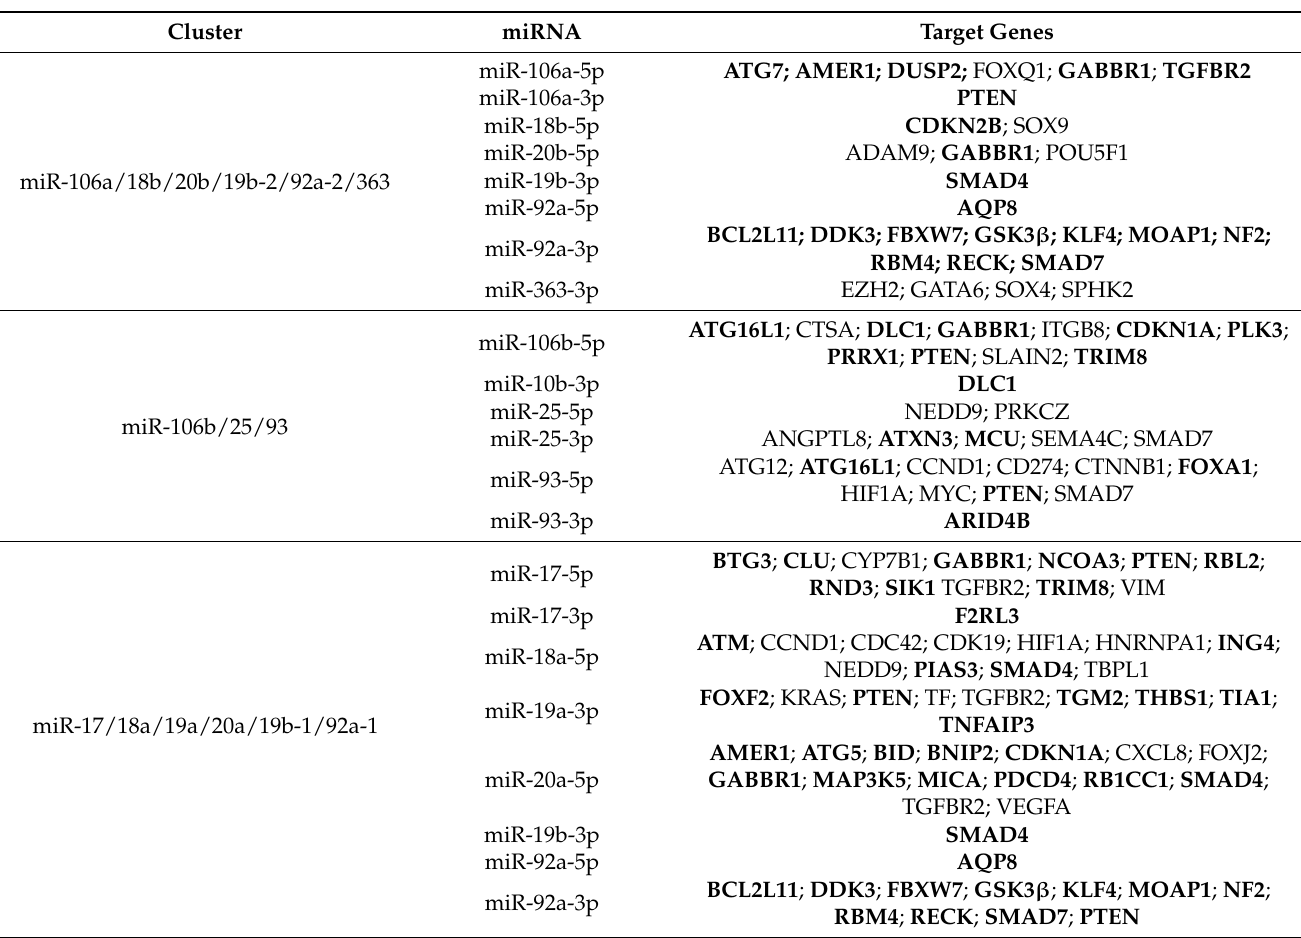
Table 6. List of target genes of up-regulated miRNA